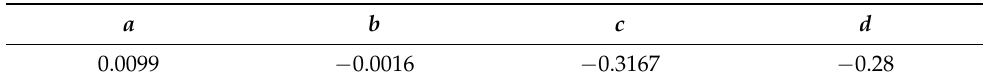
Table 4. Probability density model parameters of